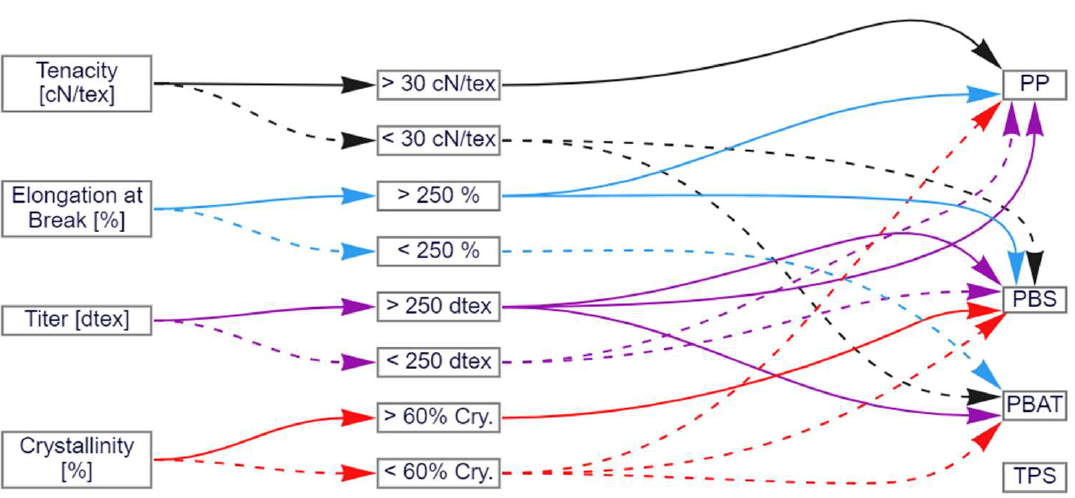
Figure 17. Decision tree based on the spinning trials discussed in this study.